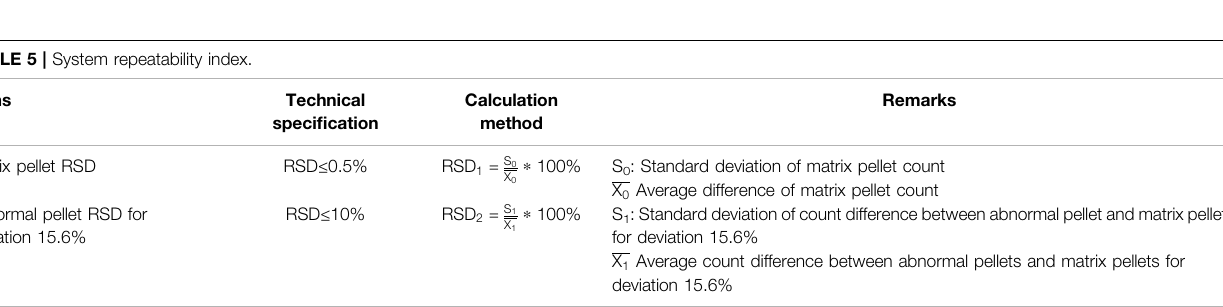
TABLE 5 | System repeatability